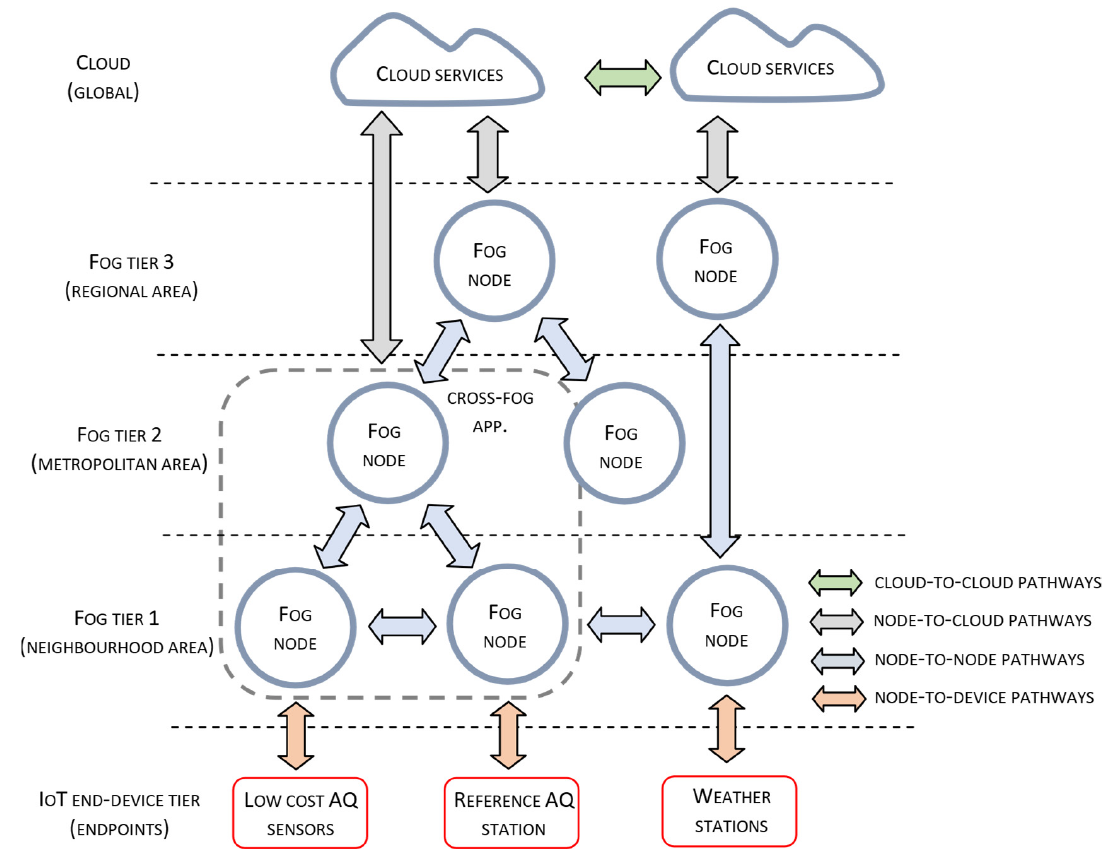
Figure 1. Tiered fog-based architecture for air quality monitoring.